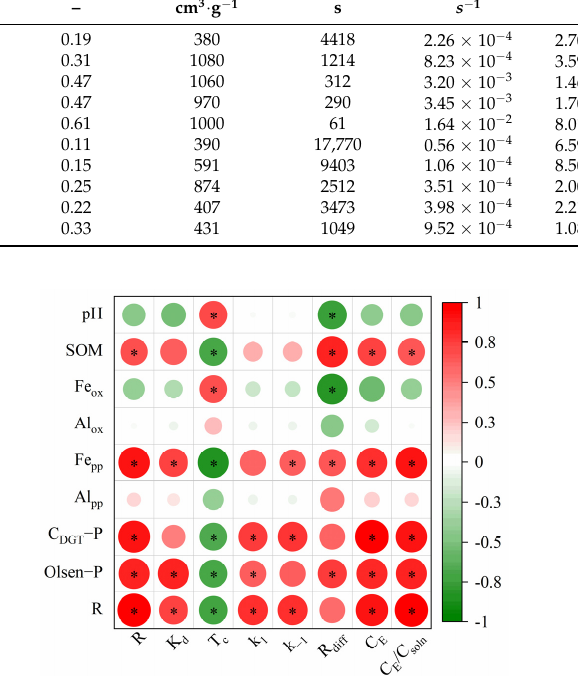
Figure 5. Pearson correlation analysis of the P kinetic resupply parameters and soil properties during the fifth maize season. “*” indicates p < 0.05.